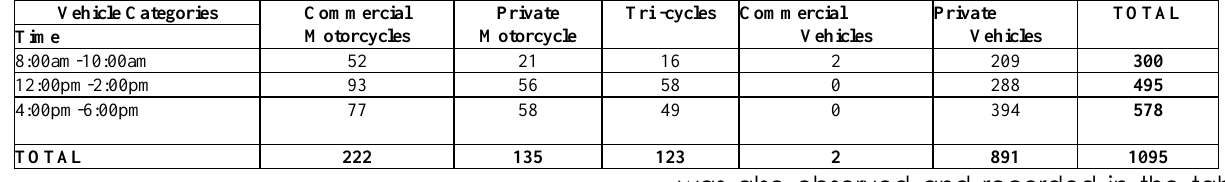
Table 4. Red Light Running Along Mandela Junction, Shiroro Road. Source: Medayese et al., 2016 Vehicle Categories